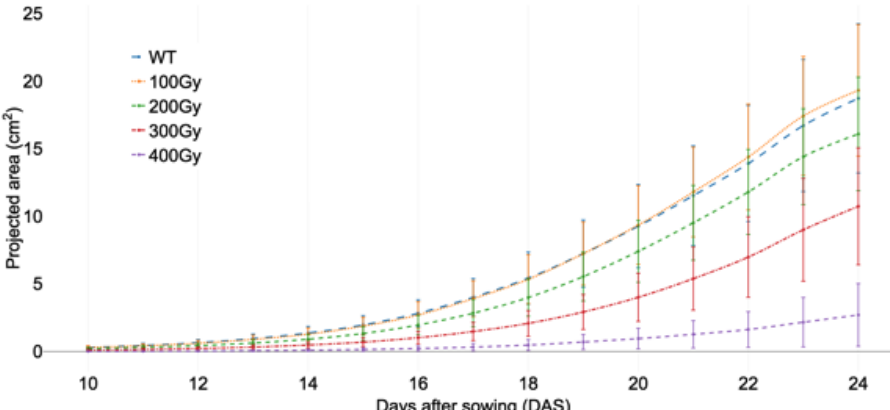
Figure 2. Comparing the growth pattern of Arabidopsis seeds irradiated at 100, 200, 300, and 400 Gy of gamma radiation ( 60 Co). Results are means ± SD ( n = 96). All treatments are shown as the average of 96 plants per treatment except 128 for wild type.